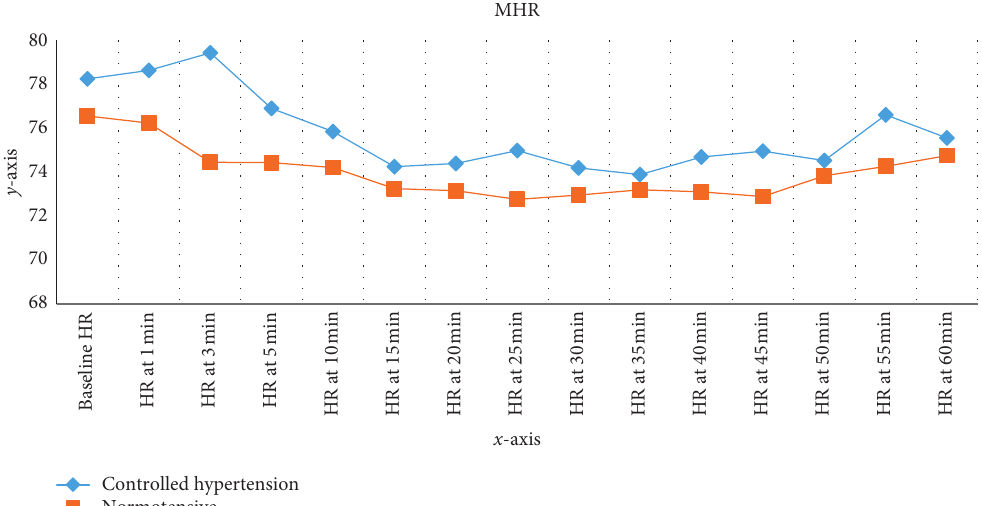
Figure 3: Variation in heart rate (HR) between two groups. The changes from baseline of the HR in the 1 st hour in postspinal anesthesia ( x - axis duration and y -axis mean of heart rate in beat per minute) at Black Lion Hospital from October 30, 2019, to January 30,